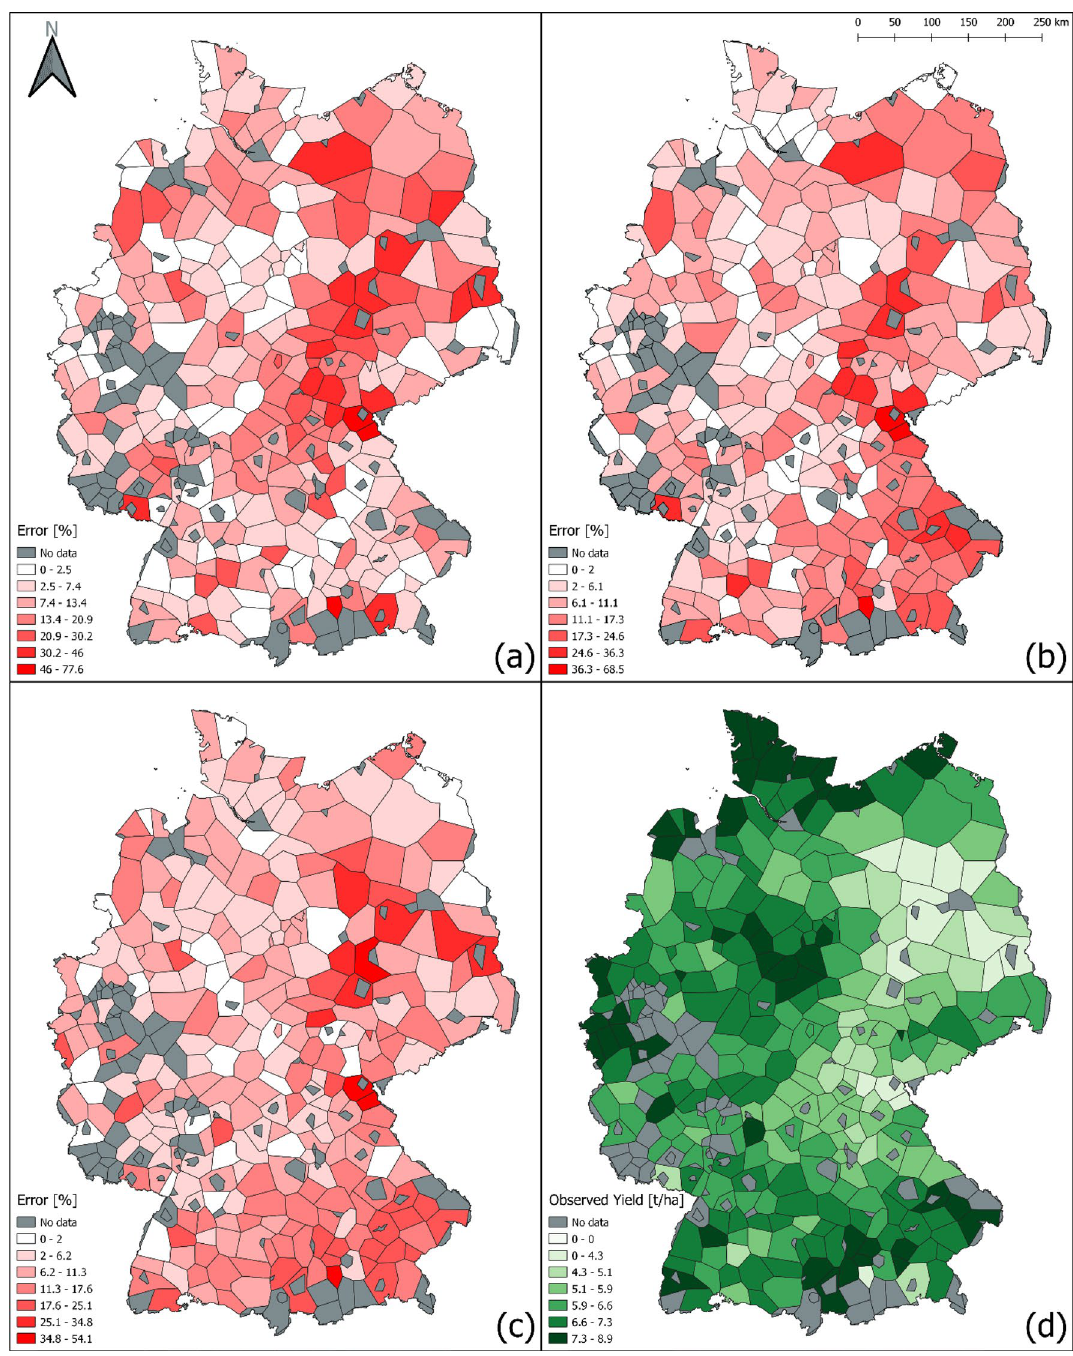
Figure 6. Percentage prediction error in winter wheat yield using ( a ) CNN, ( b ) DNN, ( c ) XGBoost models, and ( d ) distribution of observed yield (ground truth) in 271 counties. The counties in dark gray color are indicative of non-availability of ground truth data in that county in 2019. Figures were created using QGIS software version -3.18.3, https:// qgis. org/ en/ the prediction outputs. Parts of the plots in red and blue indicate the range of feature values that positively and negatively affect the yield values, respectively. For instance, Fig. S2 shows that DUL lower than 0.27 cm 3 cm −3 negatively contributes to the yield values. Also, Fig. S3 shows that higher radiation values around week seven after wheat planting negatively affects the yield values. Fig. S4 suggests that maximum temperature around week eight after wheat planting has a positive relationship with the yield values. Based on Fig. S5, higher precipitation amounts around week 49 negatively affects yield values. Additionally, using SHAP explanation force plots, three instances with the highest, median, and lowest yield values were selected to explain the effects of their features on the predicted yield (Fig. 8). Force plots are effec- tive in interpreting the prediction value of the model in critical instances. The contribution of each feature to